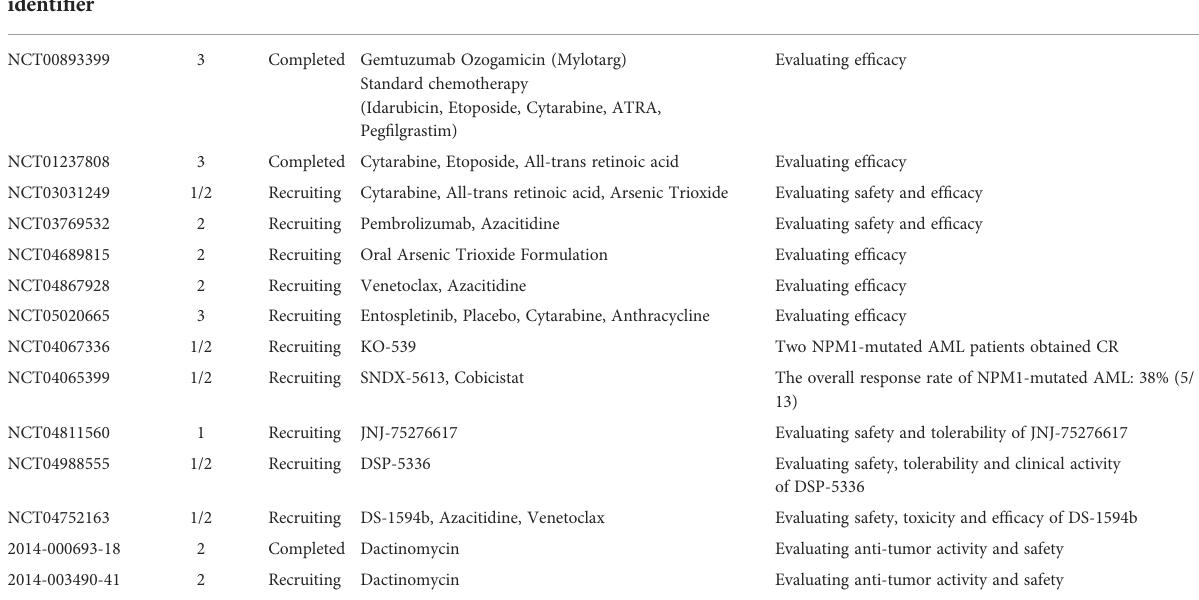
TABLE 2 Summary of ongoing or completed clinical trials in NPM1-mutated AML.